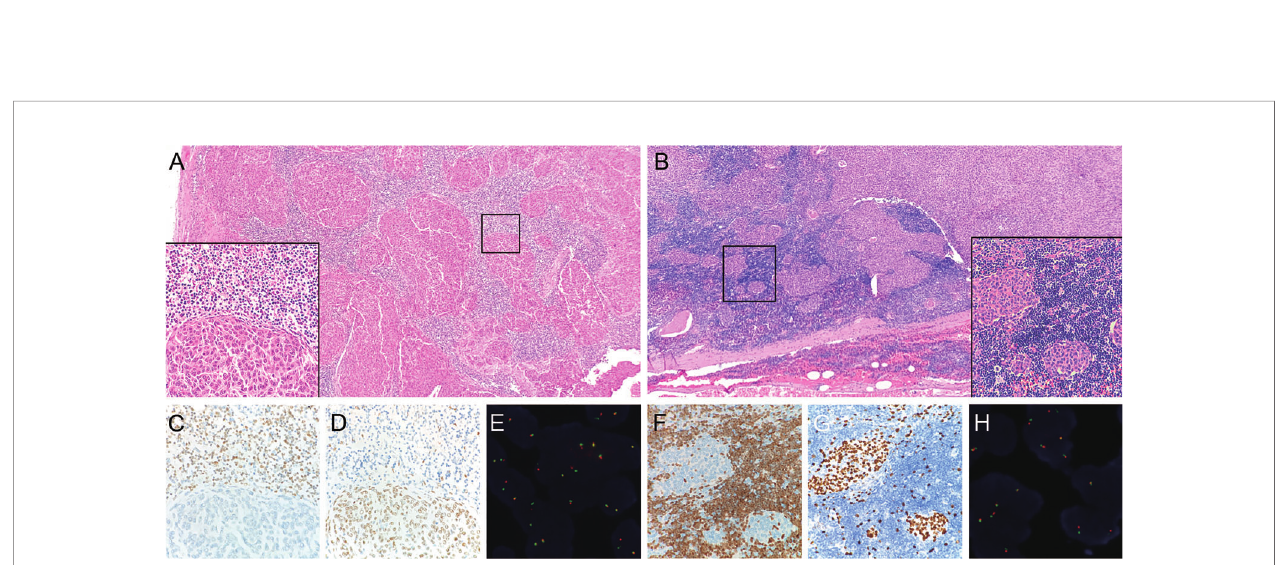
FIGURE 2 | Micronodular-like growth pattern in metaplastic thymoma. (A) This growth pattern accounts for 50% of the tumor size in case 5, H&E staining at 4X magni fi cation. The box in the left bottom shows a clear border between epithelioid cell nests and lymphoid stroma, H&E staining at 40X magni fi cation. (B) Micronodular-like growth pattern is focally present in case 10, H&E staining at 4X magni fi cation. (C) TDT-positive lymphocytes are not present in epithelial cell components of case 5. (D, G) P63 outline the epithelial cells. (F) TDT-positive lymphocytes are scattered in epithelioid cell nests of case 10. (E, H) Micronodular-like growth epithelioid cell nests all display narrow split signals in the assays using MAML2 dual color break apart probe.